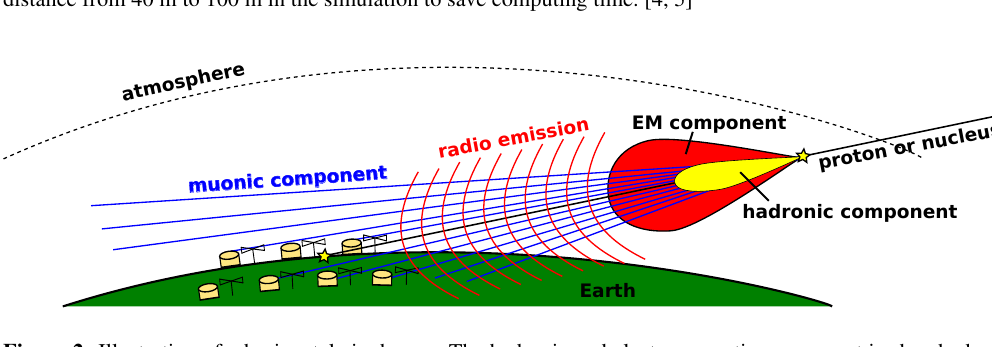
Figure 1. Field strength of the radio emission as a function of ground position for CoREAS simulations of primary proton showers of 10 18 eV for di ff erent zenith angles. The white box marks the change of antenna distance from 40 m to 100 m in the simulation to save computing time. [4, 5]